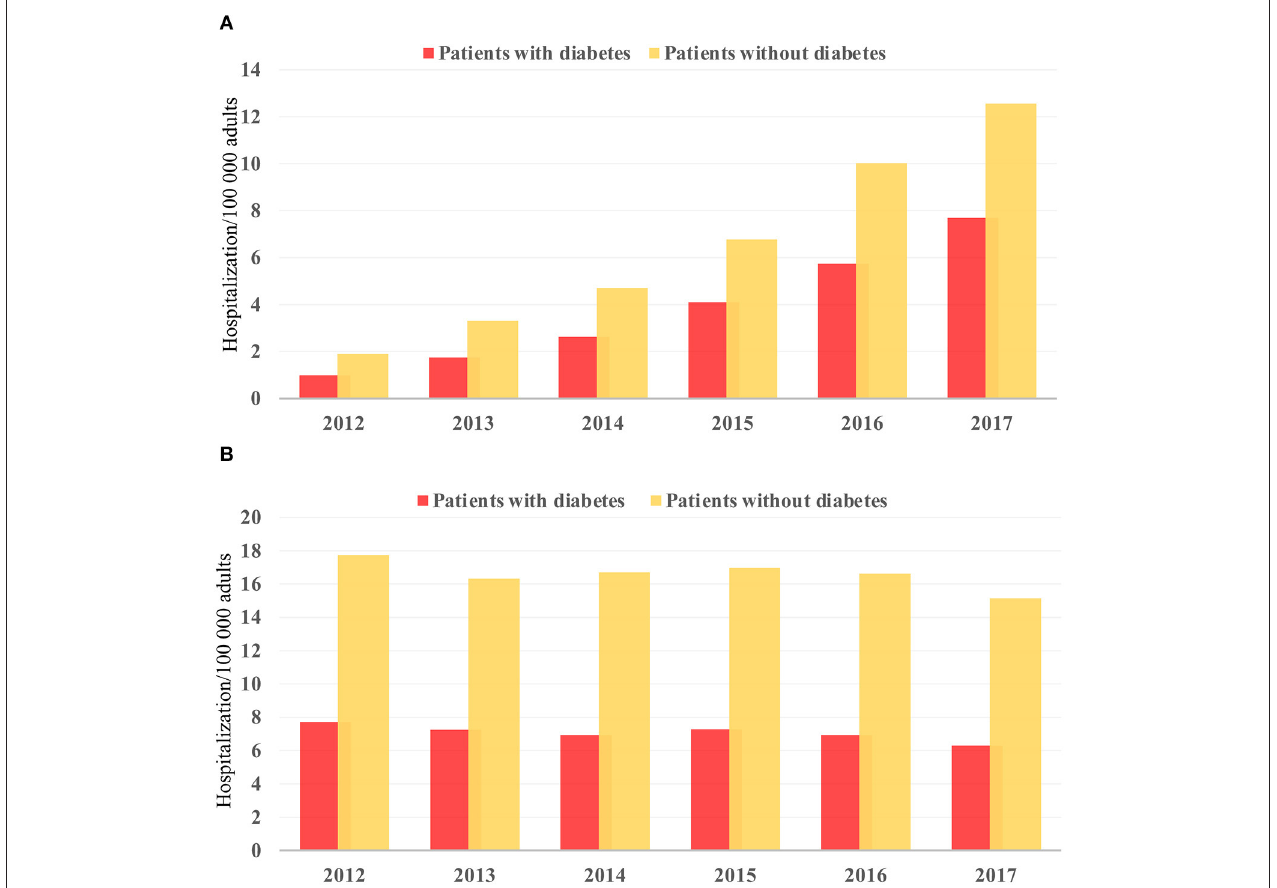
FIGURE 2 | Temporal trend in hospitalization/100,000 US adults from 2012 to 2017 in (A) TAVR and (B) sAVR patients.